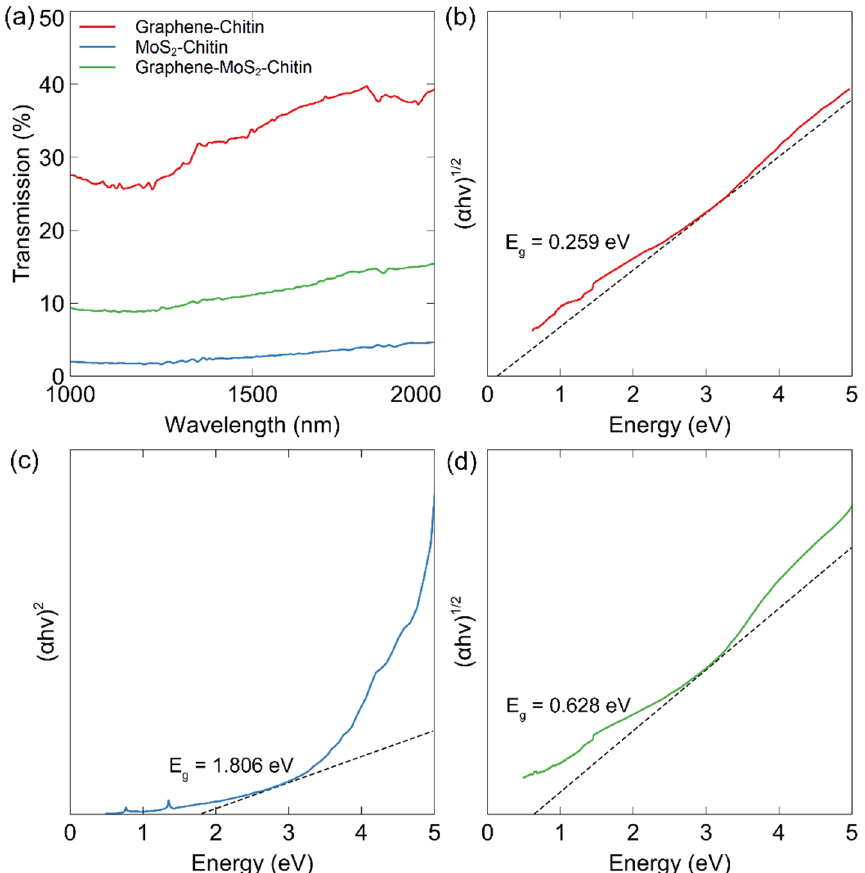
Figure 8. UV-Vis-NIR spectrum of graphene-MoS 2 -chitin film; ( a ) transmission spectrum and Tauc plot of ( b ) graphene-chitin, ( c ) MoS 2 -chitin, and ( d ) graphene-MoS 2 -chitin.